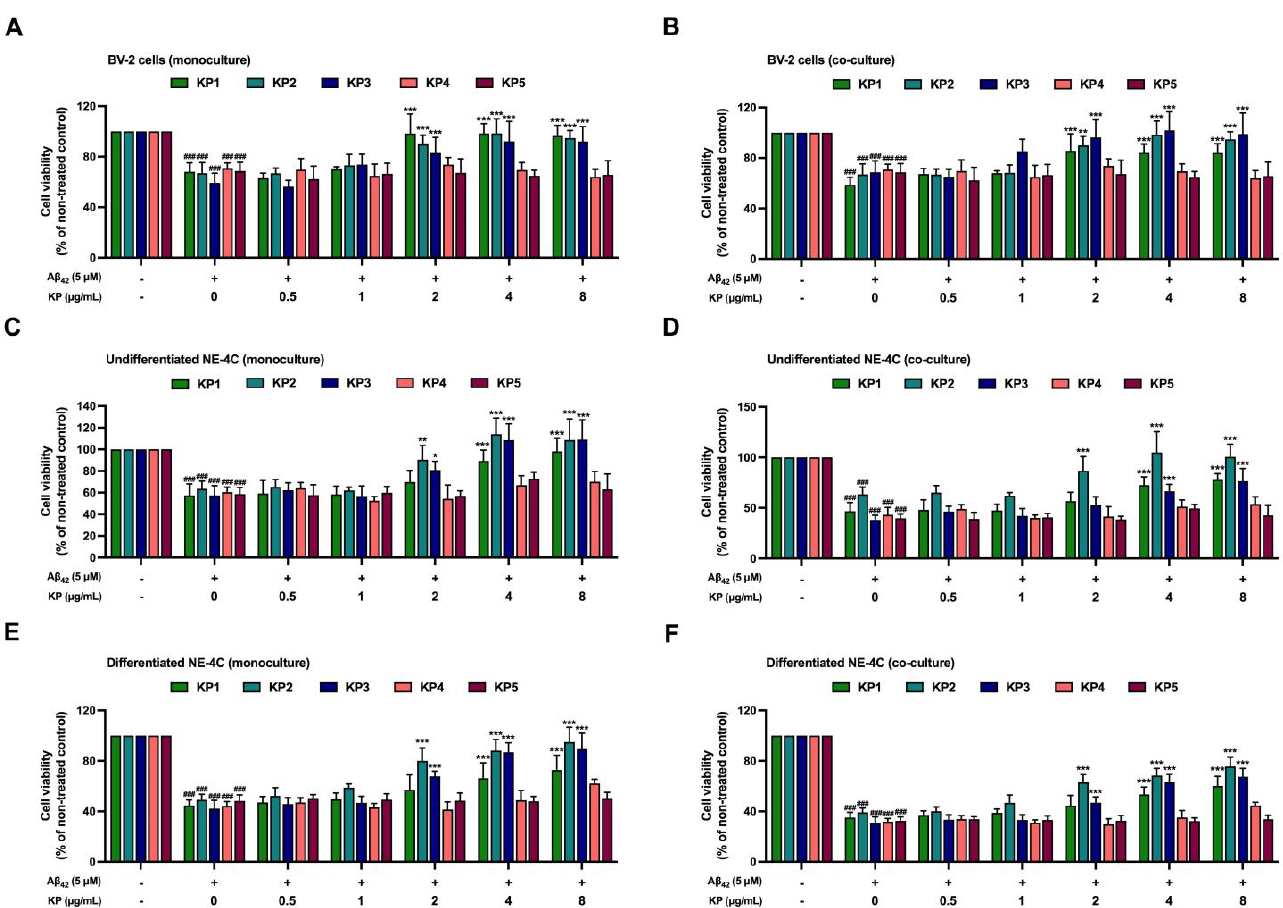
Figure 3. Protective effects of five K. parviflora extracts against A β 42 -induced neuronal cell death in both NE-4C monoculture and co-culture between NE-4C and BV-2 cells determined using an XTT assay. ( A ) BV-2 monoculture, ( B ) BV-2 co-culture, ( C ) undifferentiated, NE-4C monoculture, ( D ) undifferentiated NE-4C co-culture, ( E ) differentiated NE-4C monoculture, and ( F ) differentiated NE-4C co-culture. Values are mean ± SD of three independent experiments. The ### indicates a significant difference between the control and cells exposed to A β 42 peptides without KP extract at p < 0.001 using one-way ANOVA followed by Tukey’s test. The * indicates a significant difference between cells exposed to A β 42 peptides without KP extract compared to cells exposed to A β 42 peptides and various concentrations of KP extract (0.5–8 µ g/mL) using one-way ANOVA followed by Tukey’s test. *, p < 0.05, **, p < 0.01, ***, p <